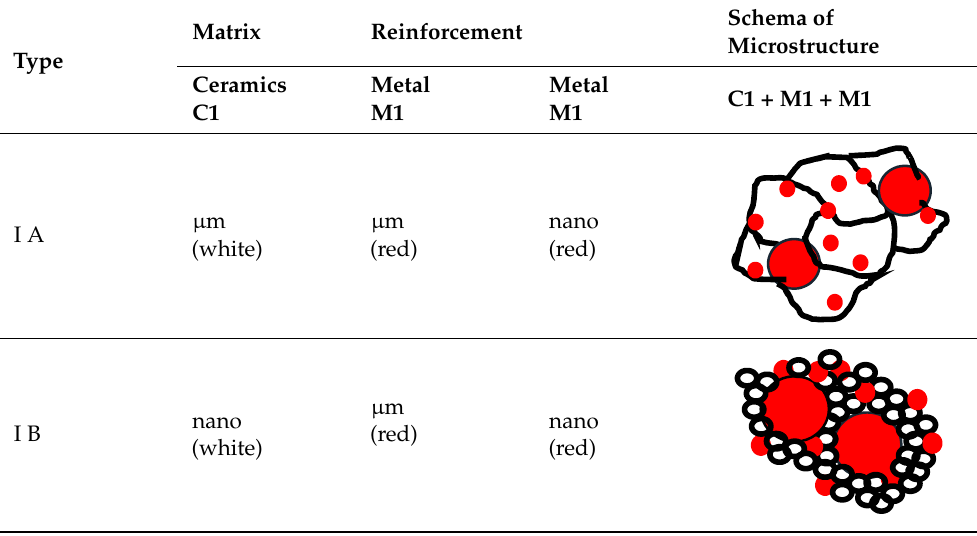
Figure 4. SEM images of ceramic–metal composites microstructure represent type IA from Table 1; Al 2 O 3 ‐ Ni, Ni particles (white) located in ceramic matrix. Source: results obtained under supervision of K. Konopka.